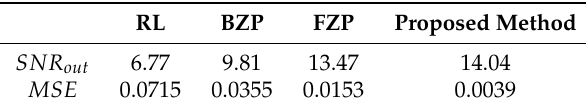
Table 6. The correction results comparison of the synthetic interferences (WGN of 15 dB) in the signal 115 of the MIT-BIH